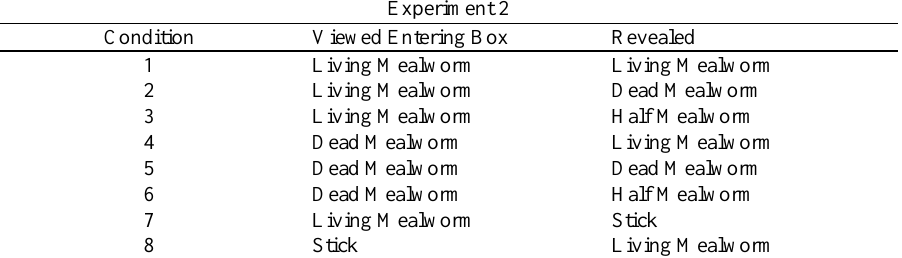
Congruent and Incongruent Conditions Presented in Experiment 2, Altering Insect Animacy Experiment 2 Condition Viewed Entering Box Revealed 1 Living Mealworm Living Mealworm Living Mealworm Dead Mealworm Dead Mealworm Living Mealworm Dead Mealworm Stick Living